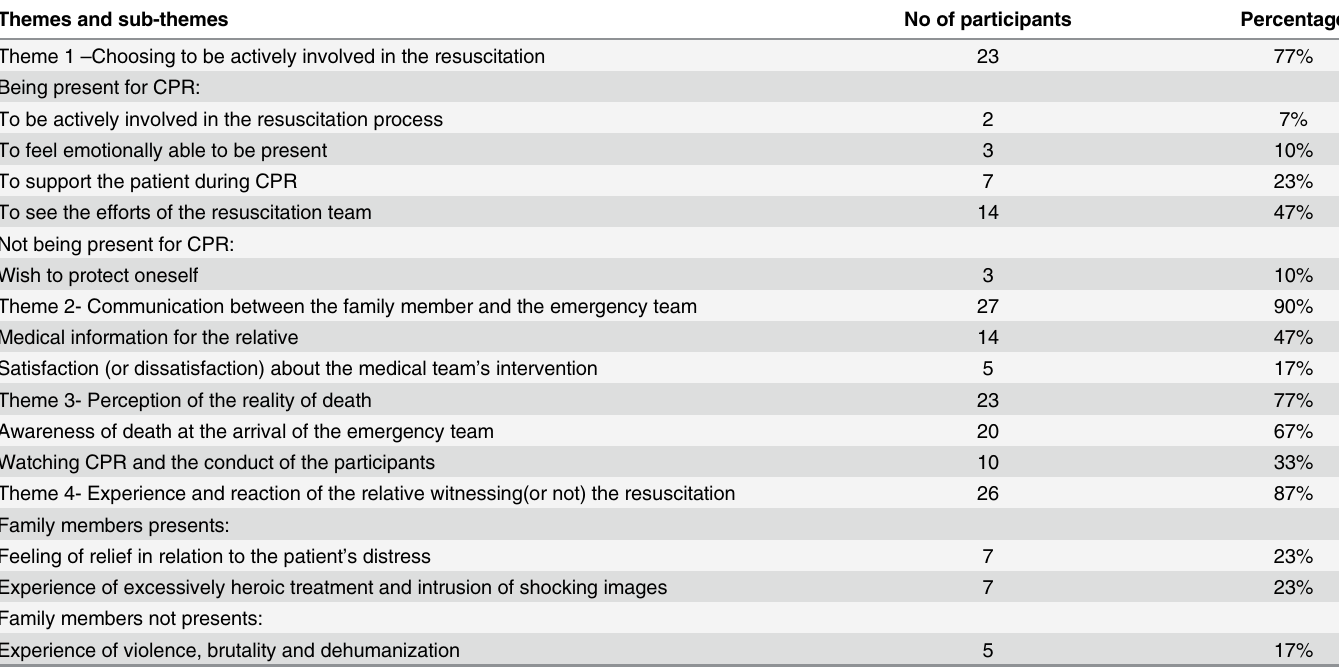
Table 2. Themes and sub-themes of